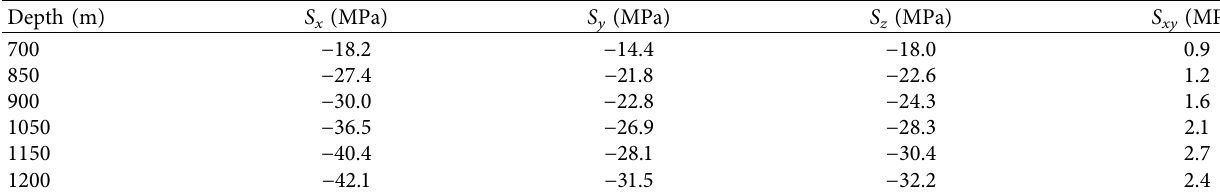
Figure 2: Finite element Table 2: Converted tectonic stress values.